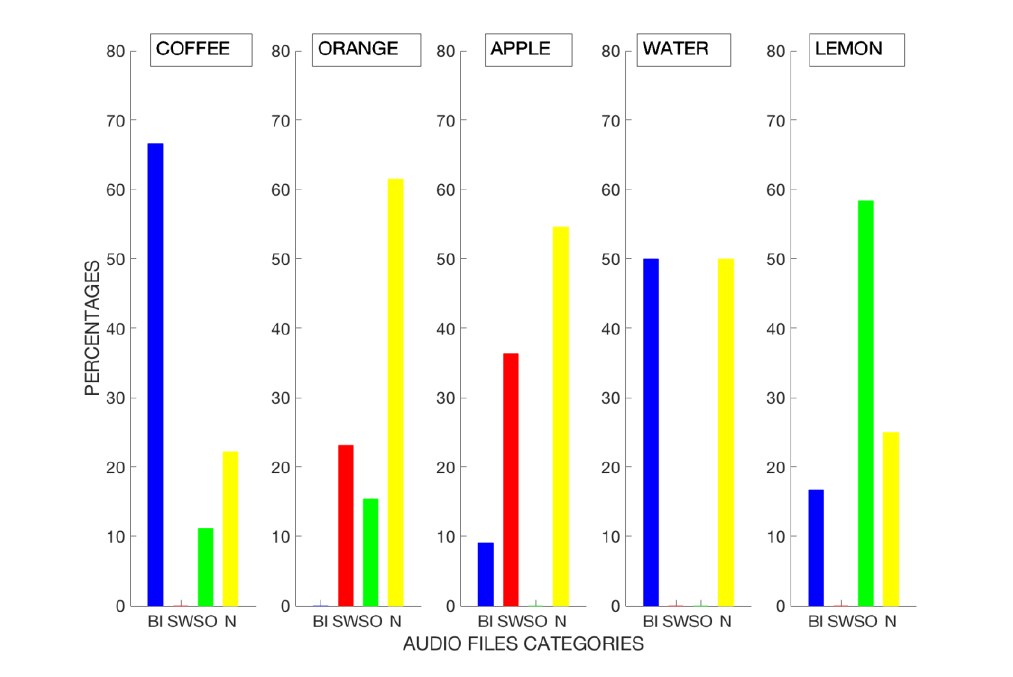
Figure 7. Percentages of audio files added to the sonic mix by both participants for each of the five drinks. BI: bitter files (blue). SW: sweet files (red). SO: sour files (green). N: neutral files